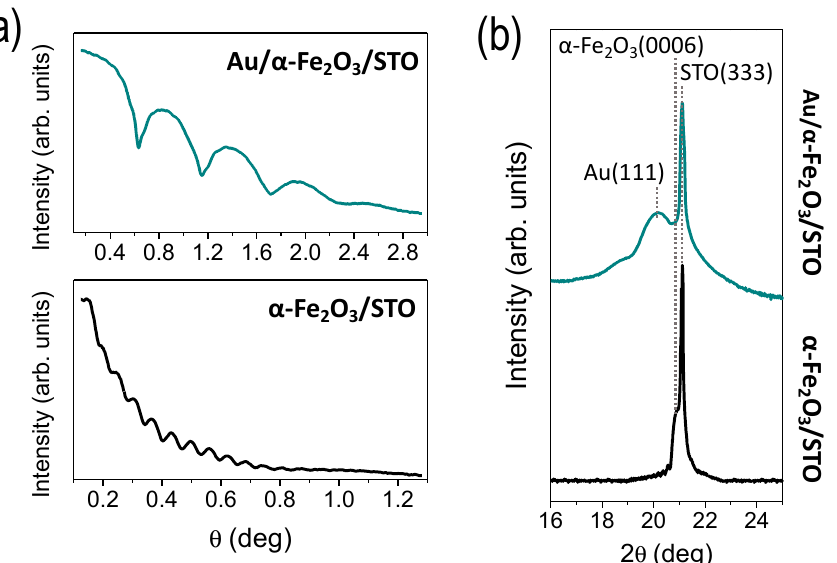
Figure 4. ( a ) Low angle XRR and ( b ) high-angle θ -2 θ scans of epitaxial α -Fe 2 O 3 layer and Au/ α -Fe 2 O 3 system grown on STO(111) substrates. Thicknesses were calculated to be 28(2) nm for the α -Fe 2 O 3 layer and 6(1) nm for the Au layer. Bragg peaks related to STO(111) substrate, Au(111) and α -Fe 2 O 3 (0001) are identified. Representative RSM measurements for the single α -Fe 2 O 3 layer and Au/ α -Fe 2 O 3 bi- layer grown on STO(111) substrates are displayed in Figure 5. Taking into account the analysis of RSM measurements, an incommensurate growth based on the non-coincidence of the in-plane diffraction peak maxima from both Au and α -Fe 2 O 3 layers and the STO substrate is recognized. Besides, the crystallographic coupling between the layers and the substrate is analyzed. A rotation of 30° is shown between the in-plane crystallographic axes of the α -Fe 2 O 3 layer and the STO(111) substrate and the Au layer and the α -Fe 2 O 3 layer, with the crystallographic axes between Au and STO substrate parallel. Thus, the orientation relationships between the lattices of Au and α -Fe 2 O 3 layers and the STO substrate is: (0001)[100] α -Fe2O3 (111)[110] STO for α -Fe 2 O 3 /STO(111) and (111)[110] Au (0001)[100] α -Fe2O3 (111)[110] STO for Au/ α -Fe 2 O 3 /STO(111) system, as previously re- ported [31,38].